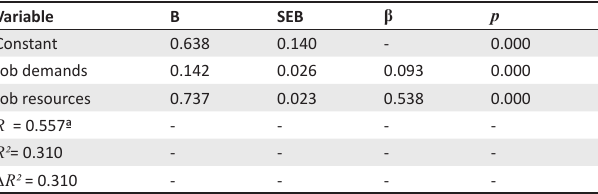
TABLE 3: Results of regression analysis in predicting work-engagement by job demands and job resources. Variable Job demands Job resources